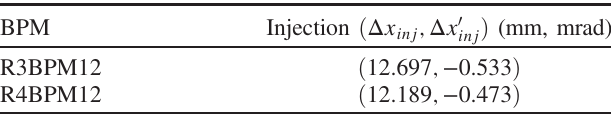
TABLE II. Results of the reconstructed phase space coordinates at the injection point, based on the measured data.